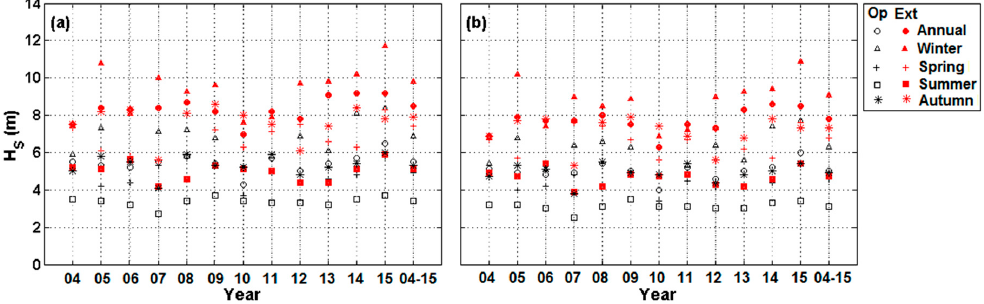
Figure 8. Annual and seasonal operational (Op) and extreme (Ext) H s thresholds (m) at ( a ) BA and ( b ) BB.